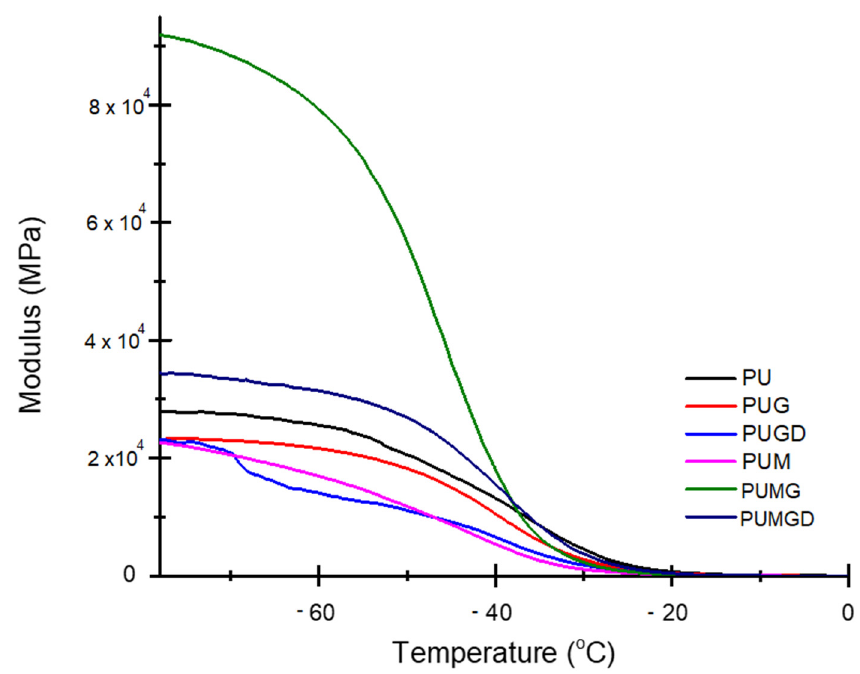
Figure 6. Storage modulus, ε ’, for the polyurea based nanocomposites.